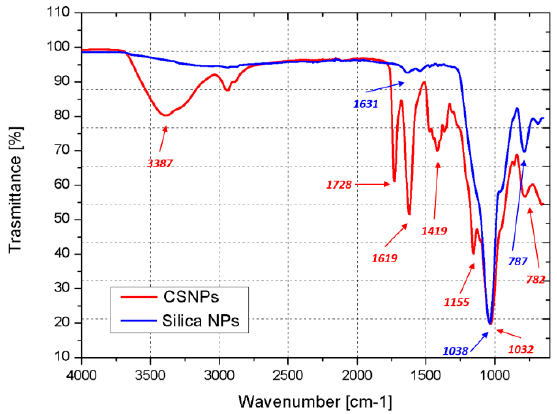
Figure 3. Fourier transform infrared (FTIR) spectra of functionalized silica nanoparticles (NPs) (blue curve) and CSNPs (red curve).